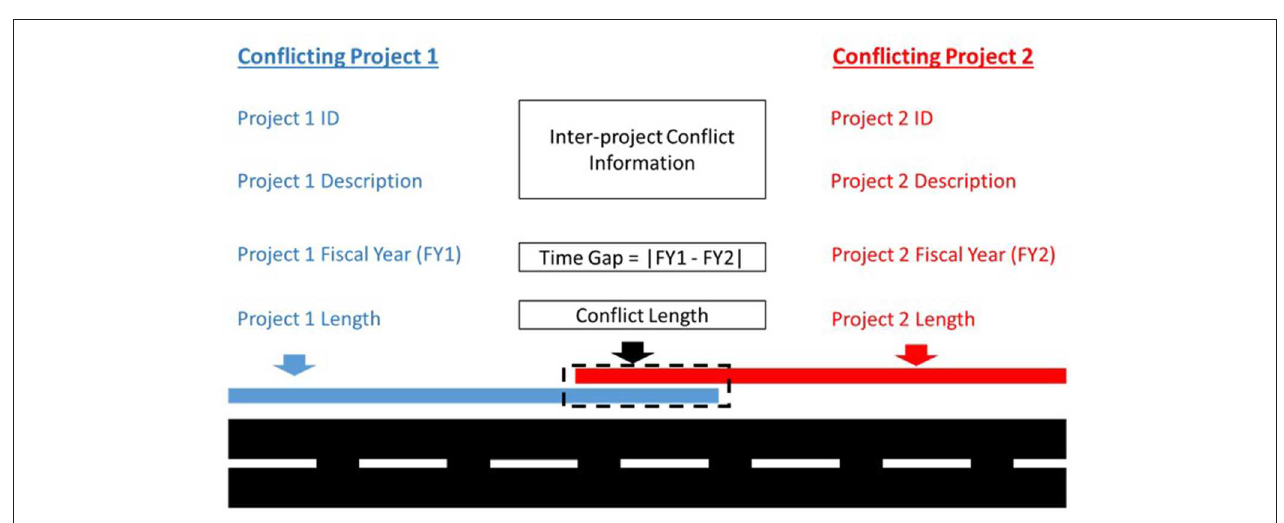
FIGURE 6 | Description of conflicting highway projects and contextual information computed.